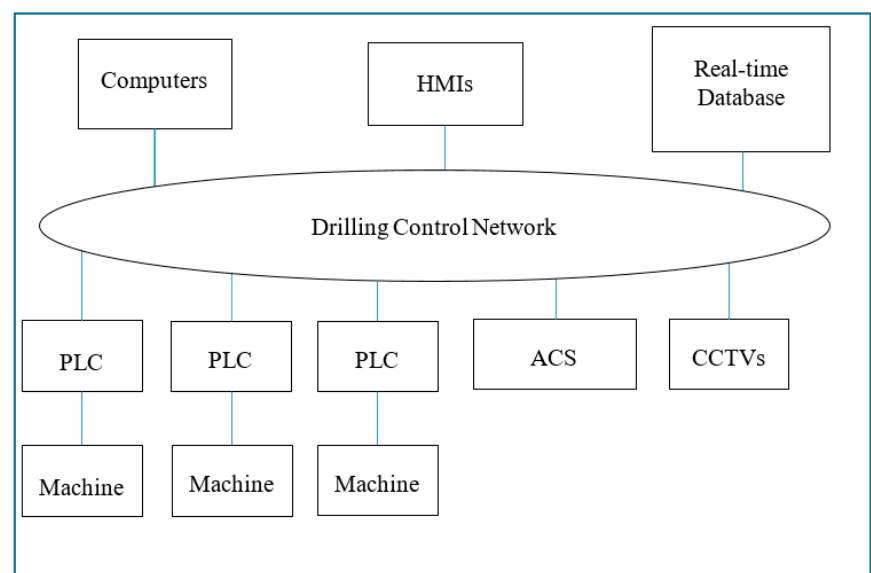
Figure 1. Structure of the Integrated Drilling System.